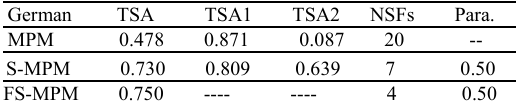
Table 6 TSAs and NSFs for German credit.